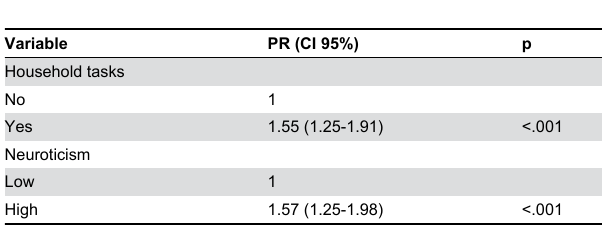
Table 3. Poisson regression model regarding household works, neuroticism level associated to sleep bruxism among